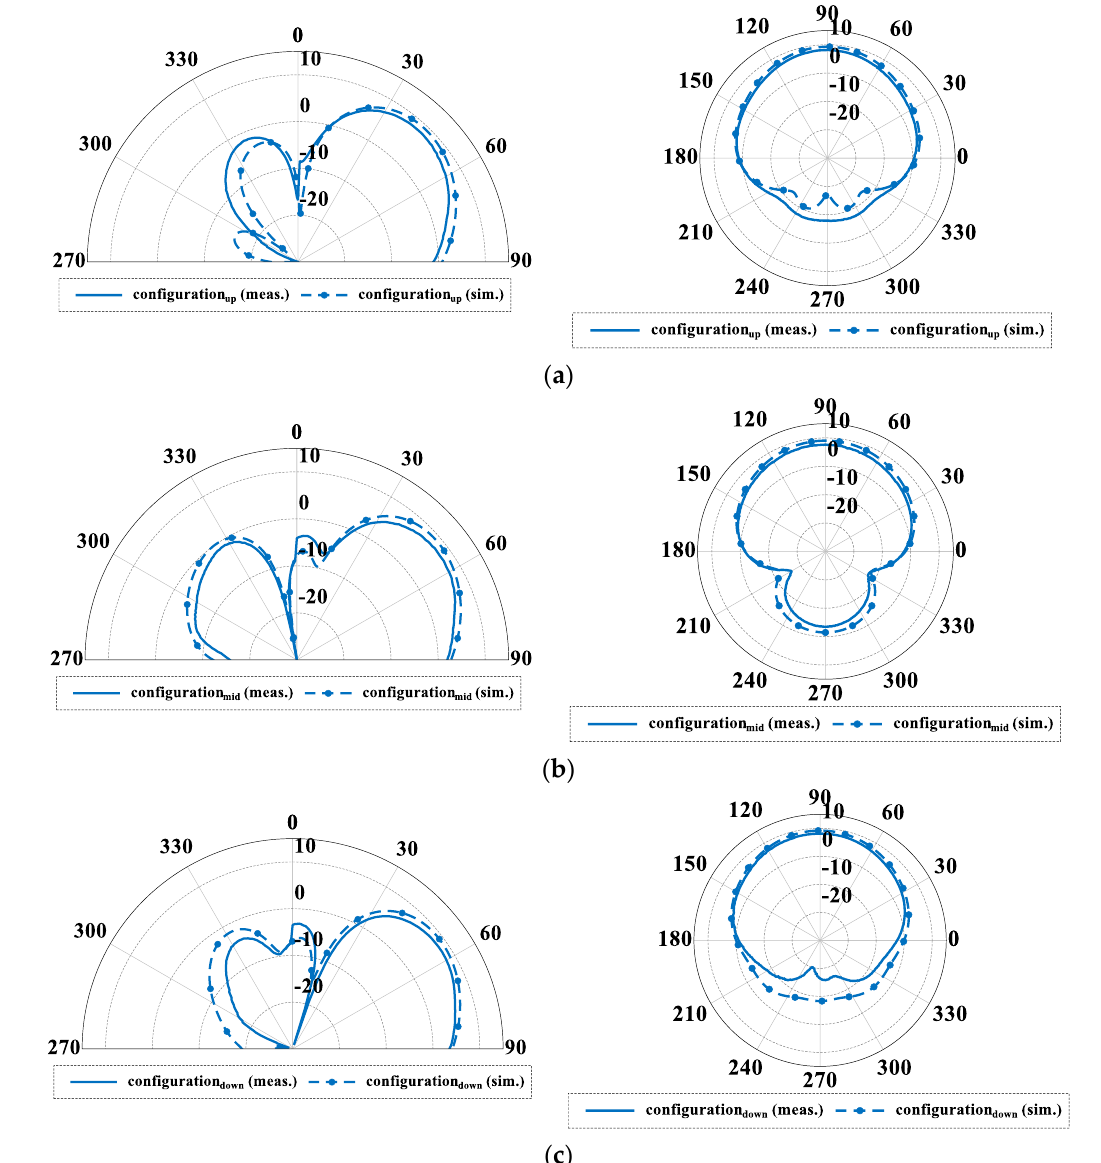
Figure 3. Simulated and measured antenna radiation patterns at 2.44 GHz in the elevation plane (for φ = 90°) and in the horizontal plane for three configurations (see text for explanations): ( a ) 𝑉 𝑈𝑃 90 (maximum at 𝜃 𝑚𝑎𝑥_𝑢𝑝 = 46° ), ( b ) 𝑉 𝑀𝐼𝐷90 (maximum at 𝜃 𝑚𝑎𝑥_𝑚𝑖𝑑 = 52° ), and ( c ) 𝑉 𝐷𝑂𝑊𝑁90 (maximum at 𝜃 𝑚𝑎𝑥_𝑑𝑜𝑤𝑛 = 56° ).